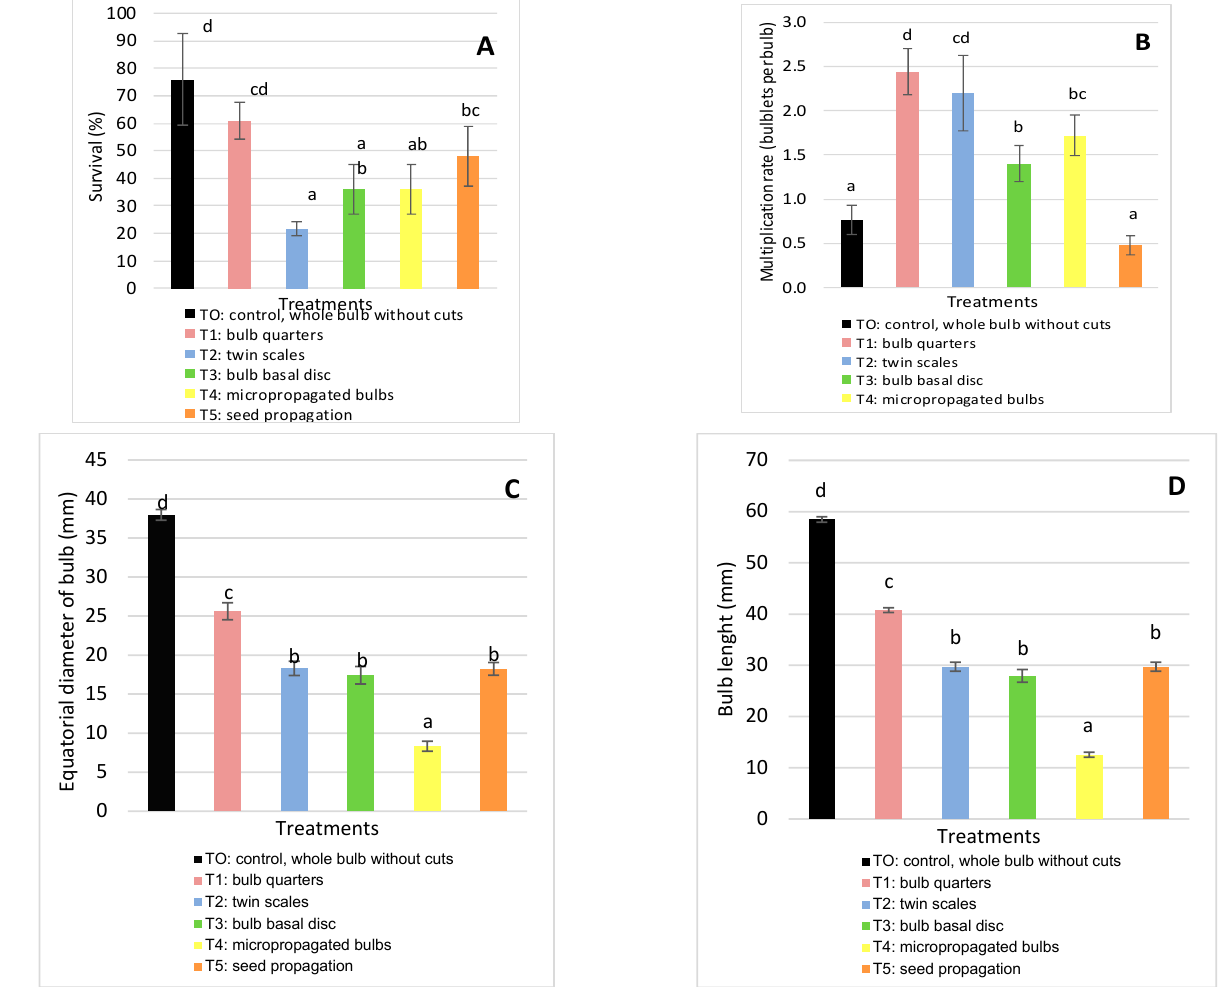
Figure 3. Effect of the propagation method on survival ( A ); multiplication rate ( B ); equatorial diameter of bulb ( C ); and bulb length ( D ). Means and standard deviation are reported. Data were analyzed by ANOVA and different letters (a, b, c, d) indicate significant differences by the Tukey test ( p < 0.05). The treatments were: T0 (Control): whole bulb, T1: bulb quarters, T2: twin scales, T3: bulb basal discs, T4 micro propagated bulbs and T5: seed propagated bulbs.